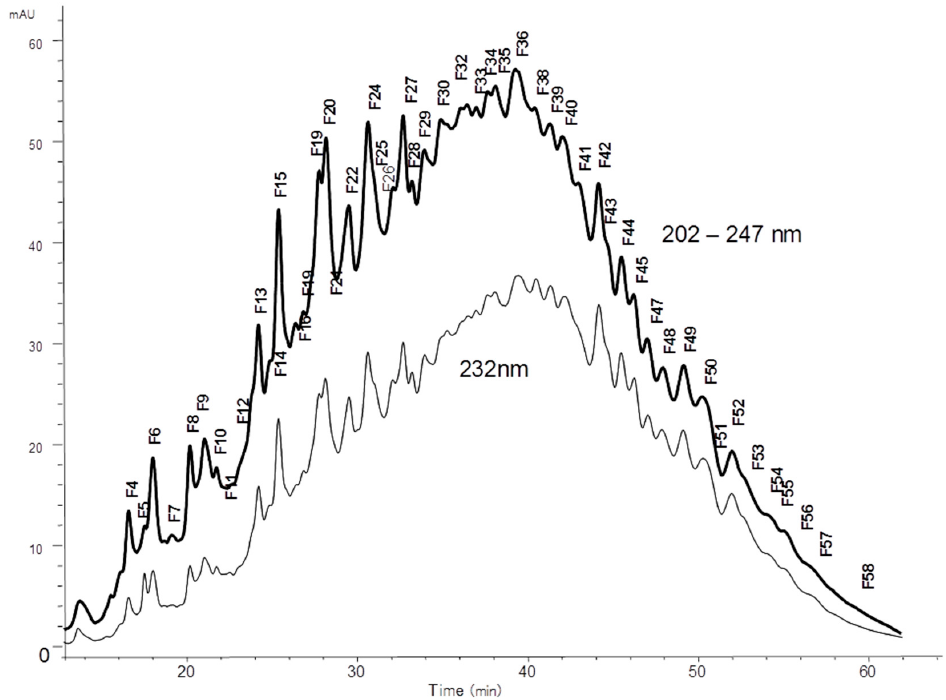
Figure 3. Preparative CTA-SAX chromatography of fraction F3.